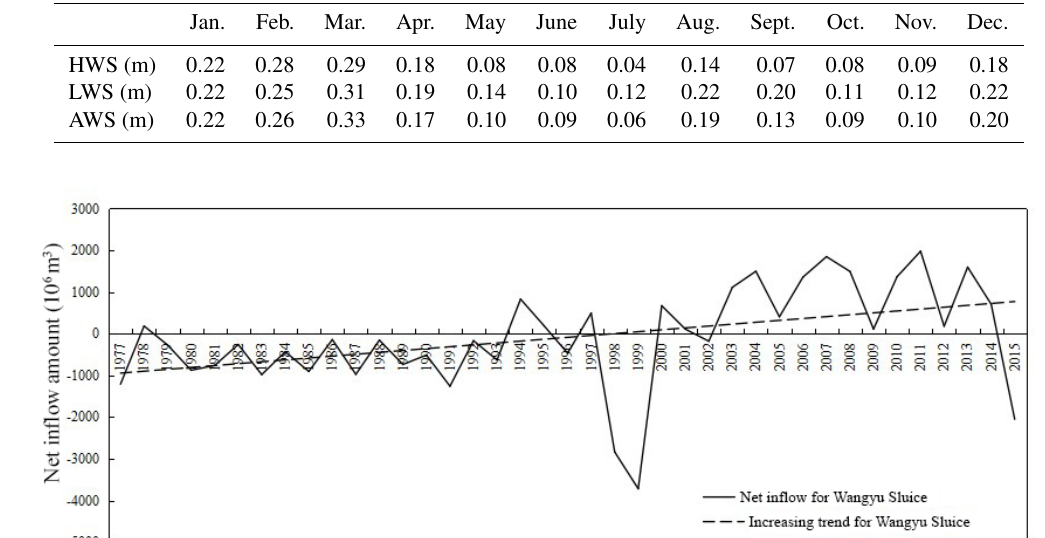
Figure 4. Increasing trend of annual net inflow amount for Wangyu Sluice.